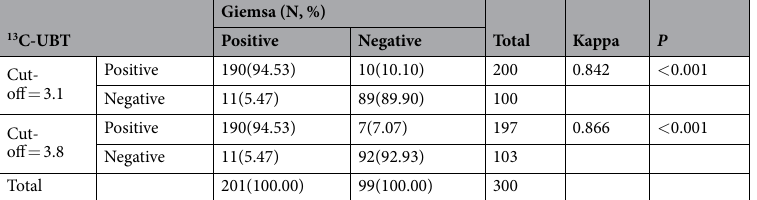
Table 3. Sensitivity and specificity of 13 C-UBT in validating subjects.